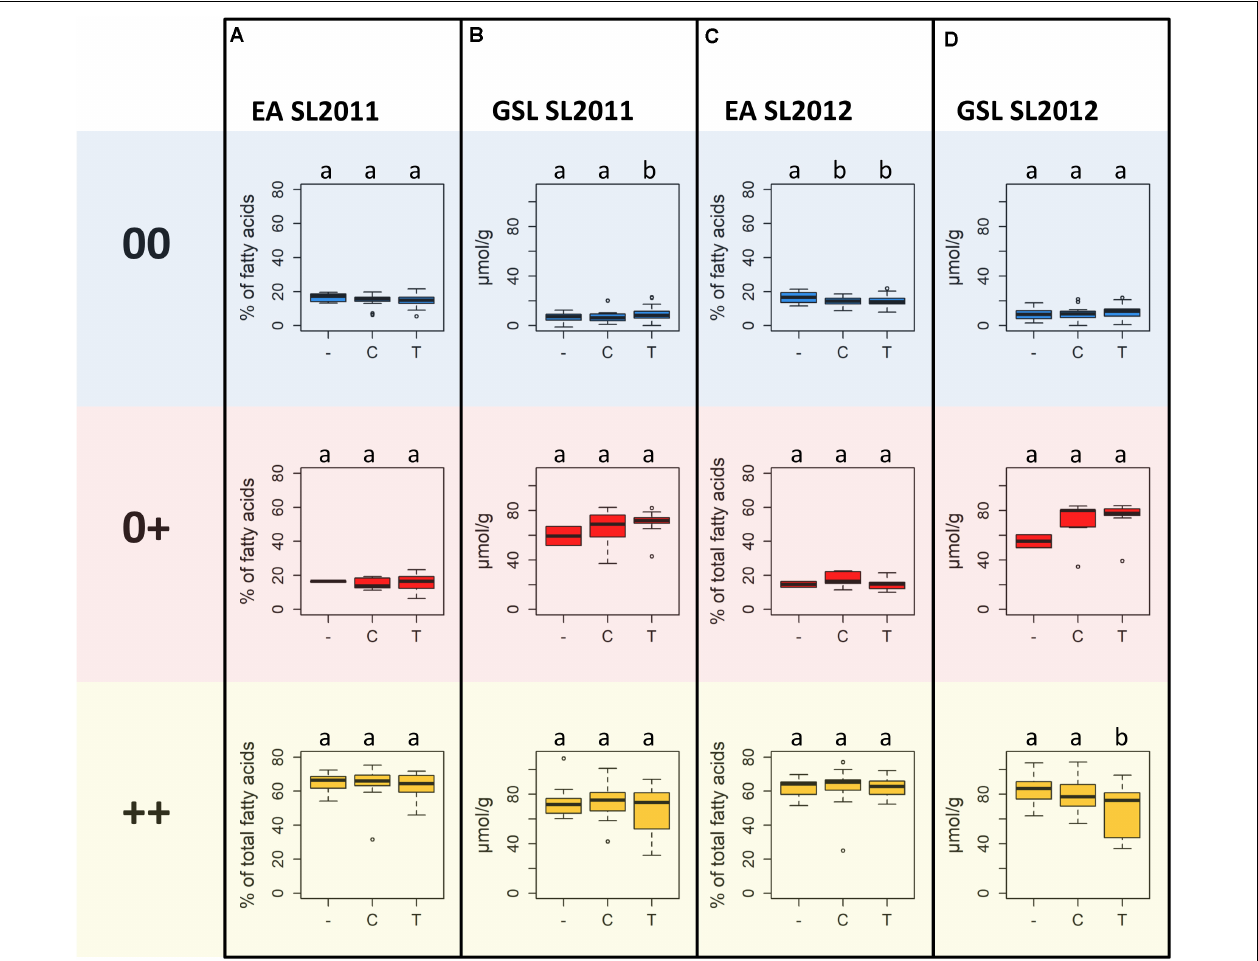
FIGURE 9 | Boxplots showing (A) seed erucic acid (EA) content of seed lot SL2011 and (B) seed glucosinolate (GSL) content of seed lot SL2011, and (C) seed EA content of seed lot SL2012 and (D) seed GSL content of seed lot SL2012 dependent on the predominant marker allele of peak marker Bn-A01-p26914512, determined for the different seed quality groups (00, low erucic acid, low glucosinolate content; 0+, low erucic acid, high glucosinolate content; ++, high erucic acid, high glucosinoate